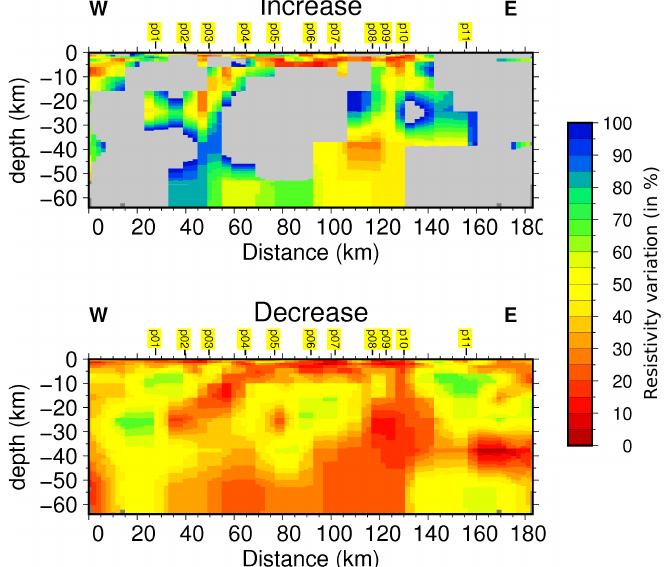
Figure A7. Results of the sensitivity analysis for the MT northern profile. On the top: increasing resistivity variations. On the bottom: decreasing variations. The grey values represent percentages greater than 100% (badly constrained values). See text for explanations.